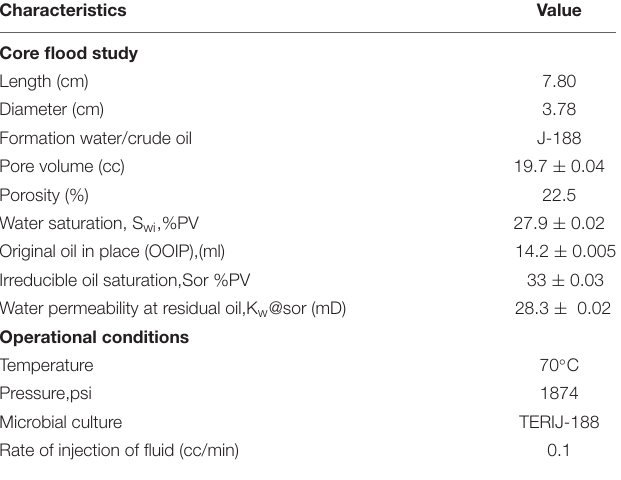
TABLE 1 | Petro-physical properties of core flood